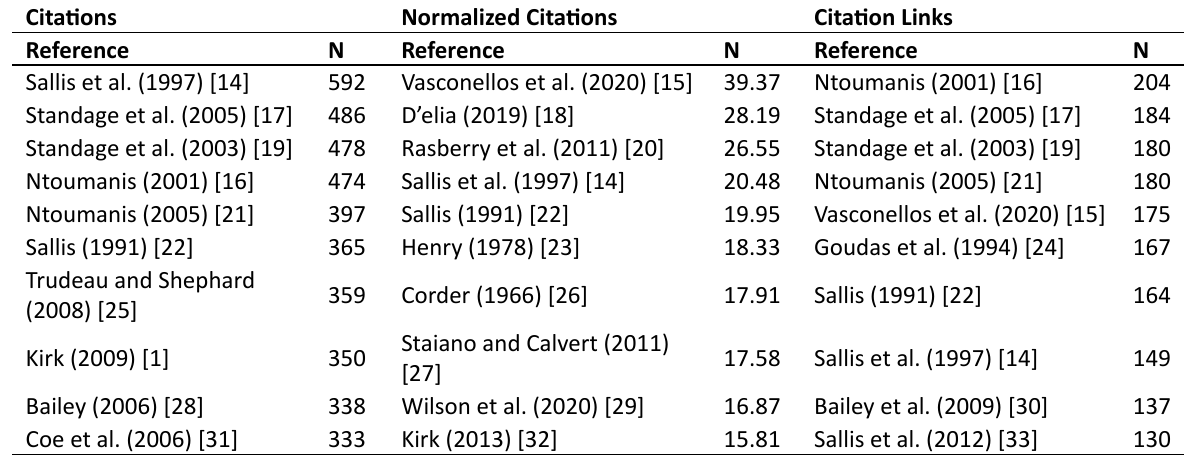
Table 1. Core references in physical education